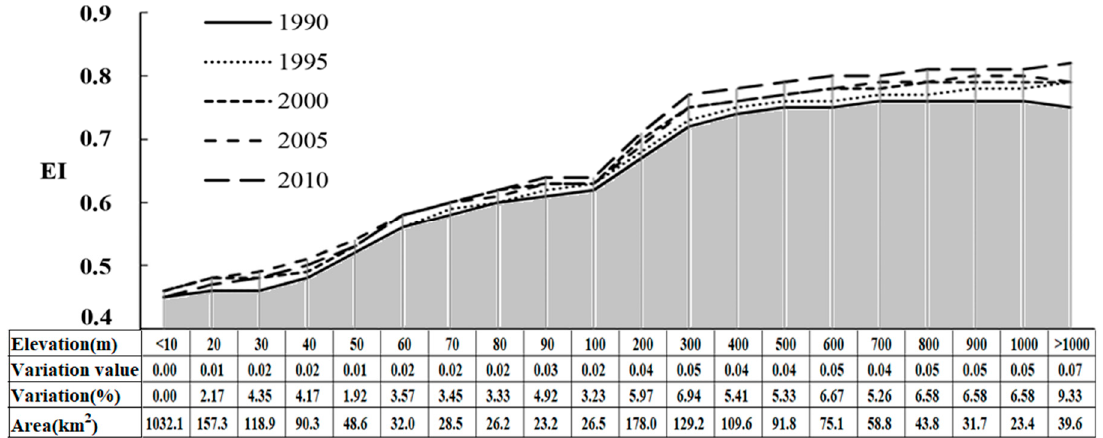
Figure 4. The influence of elevation differentiation on Eco_C in the YRD from 1990 to 2010.